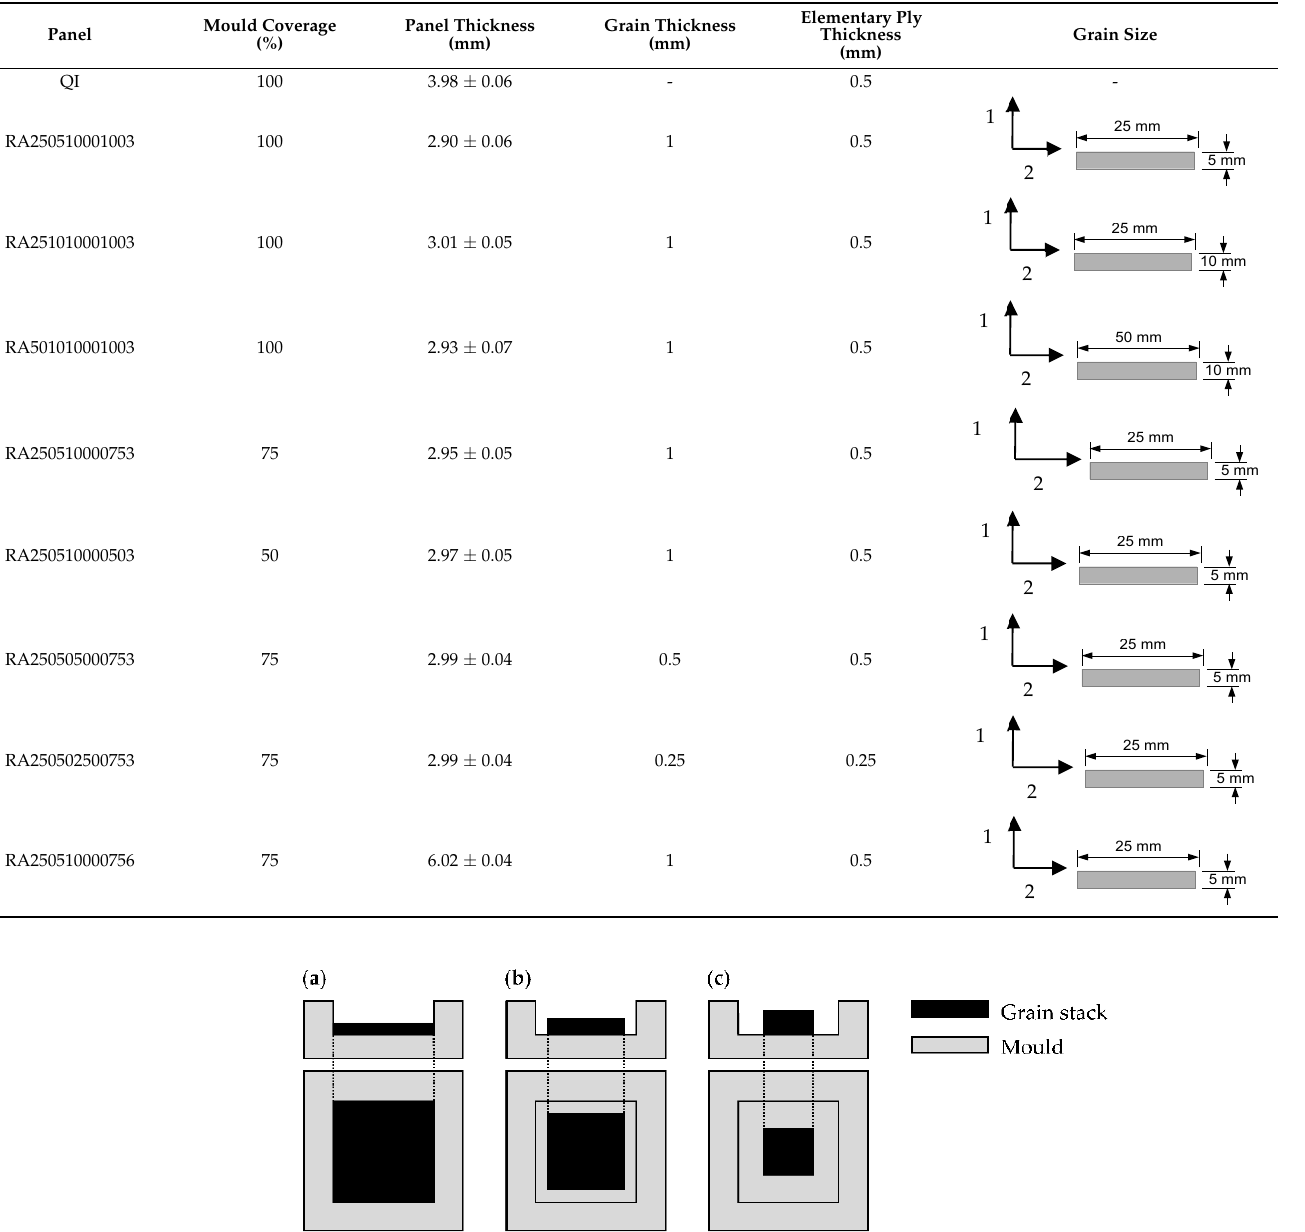
Table 1. Configurations of manufactured panel.